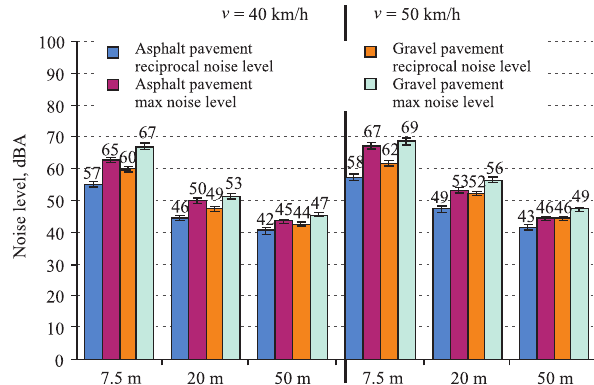
Fig. 8. Dependence of reciprocal and max noise levels on car speed when driving in wooded area on road with asphalt and gravel pavement in wintertime